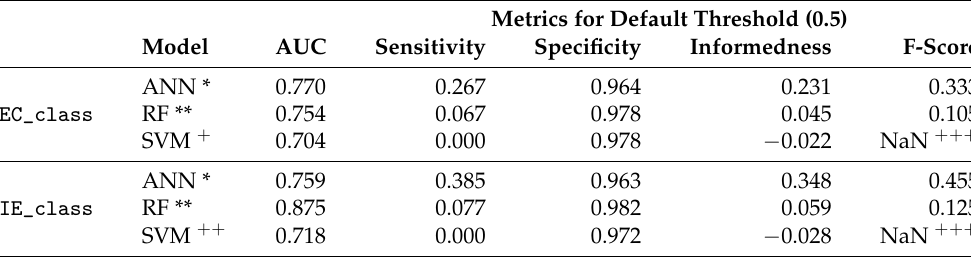
Table 5. Cross validation results of several models before tuning parameters.